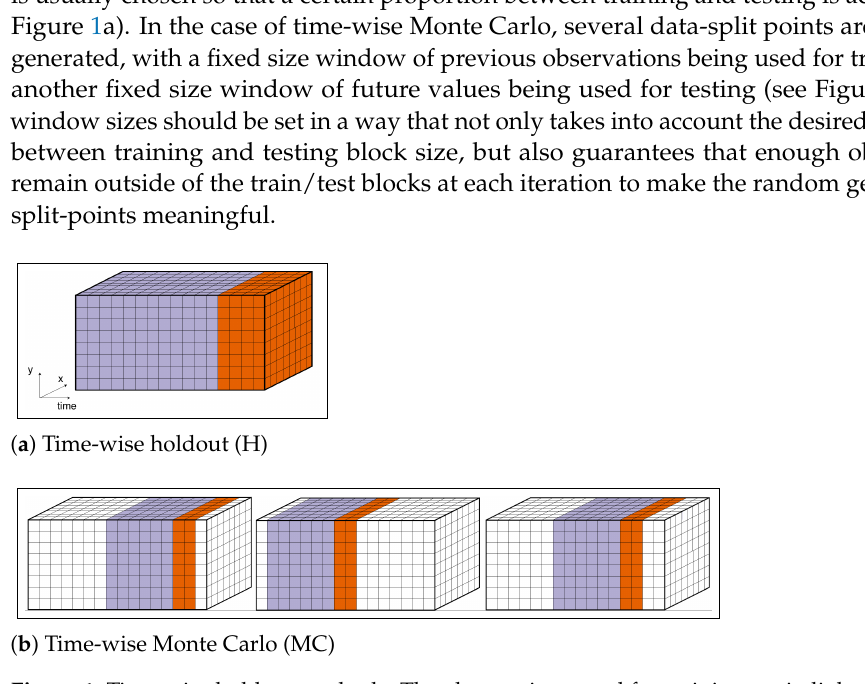
Figure 1. Time-wise holdout methods. The observations used for training are in lighter lilac, while the observations used for testing are in dark orange. Time flows from left to